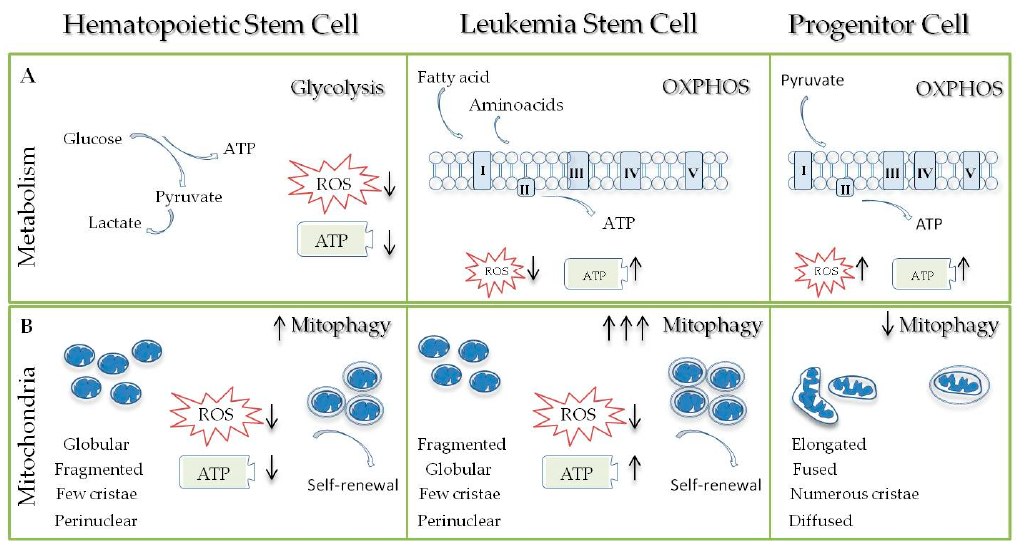
Figure 1. Metabolic regulation of Hematopoietic Stem Cells (HSCs), Leukemic Stem Cells (LSCs) and Progenitor Cells. ( A ) HSCs exhibit a low energy status, high glycolysis with resultant low ROS and low adenosine triphosphate (ATP) production. LSCs exhibit a low ROS level but high ATP production due to activation of oxidative phosphorylation (OxPHOS). Amino acid and fatty acid metabolism heavily contribute to maintain OXPHOS in LSCs. In contrast, progenitor cells exhibit high mitochondrial activity, high ROS, and ATP levels as a result of the OxPHOS process. ( B ) Hematopoietic stem cells have small motochondria, with globular and fragmented shape consistent with increased mitochondrial fission, with few cristae and localized in the perinuclear area. The mitophagy process represents a crucial mechanism in stem cell maintenance and self renewal. LSCs are characterized by high levels of autophagy in order to efficiently eliminate damaged mitochondria and reduce ROS levels since the rate of cellular stress is sustained. In contrast, progenitor cells have mitochondria with elongated and fused shape, consistent with increased mitochondrial fusion, and numerous cristae.